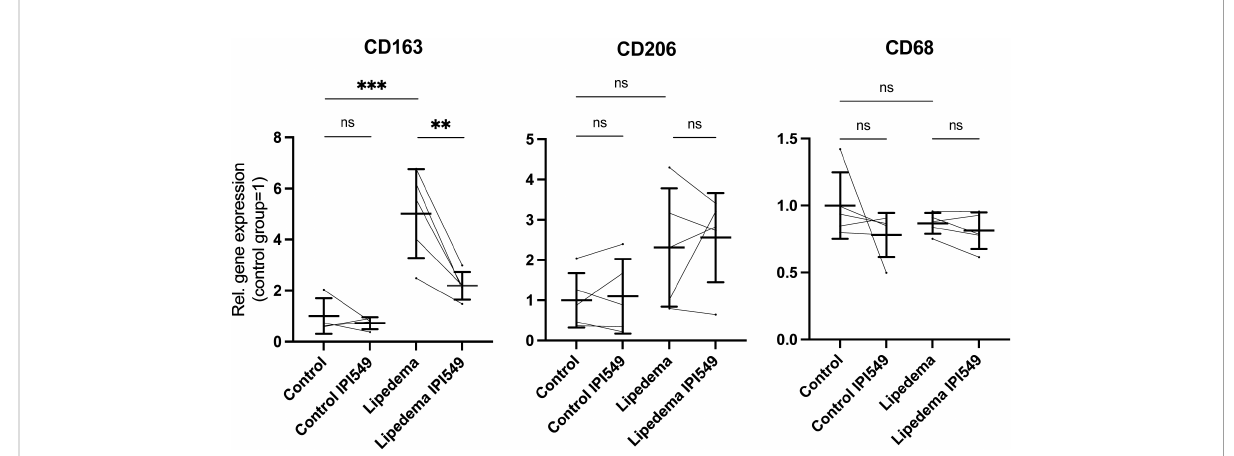
FIGURE 5 IPI-549 reduces CD163 expression in the lipedema SVF. Evaluation of the gene expression levels of CD163, CD206 and CD68 of IPI-549 treated and untreated SVF of lipedema and control patients. For the comparison between the treated and untreated expression of the same patient a